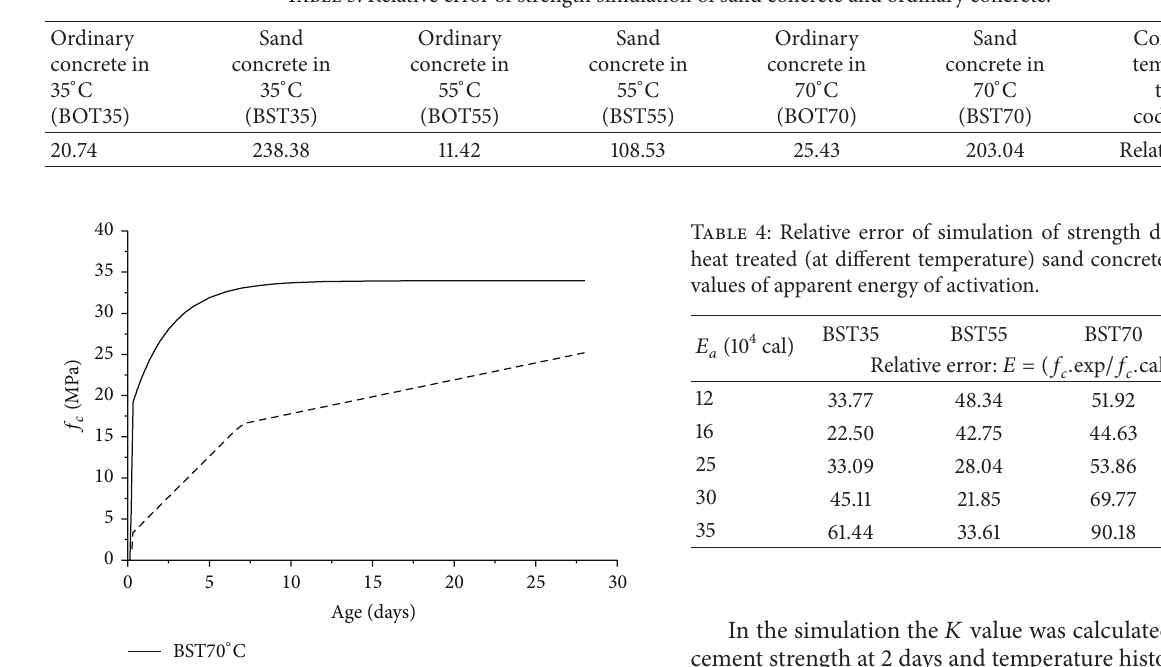
Table 3: Relative error of strength simulation of sand concrete and ordinary concrete.